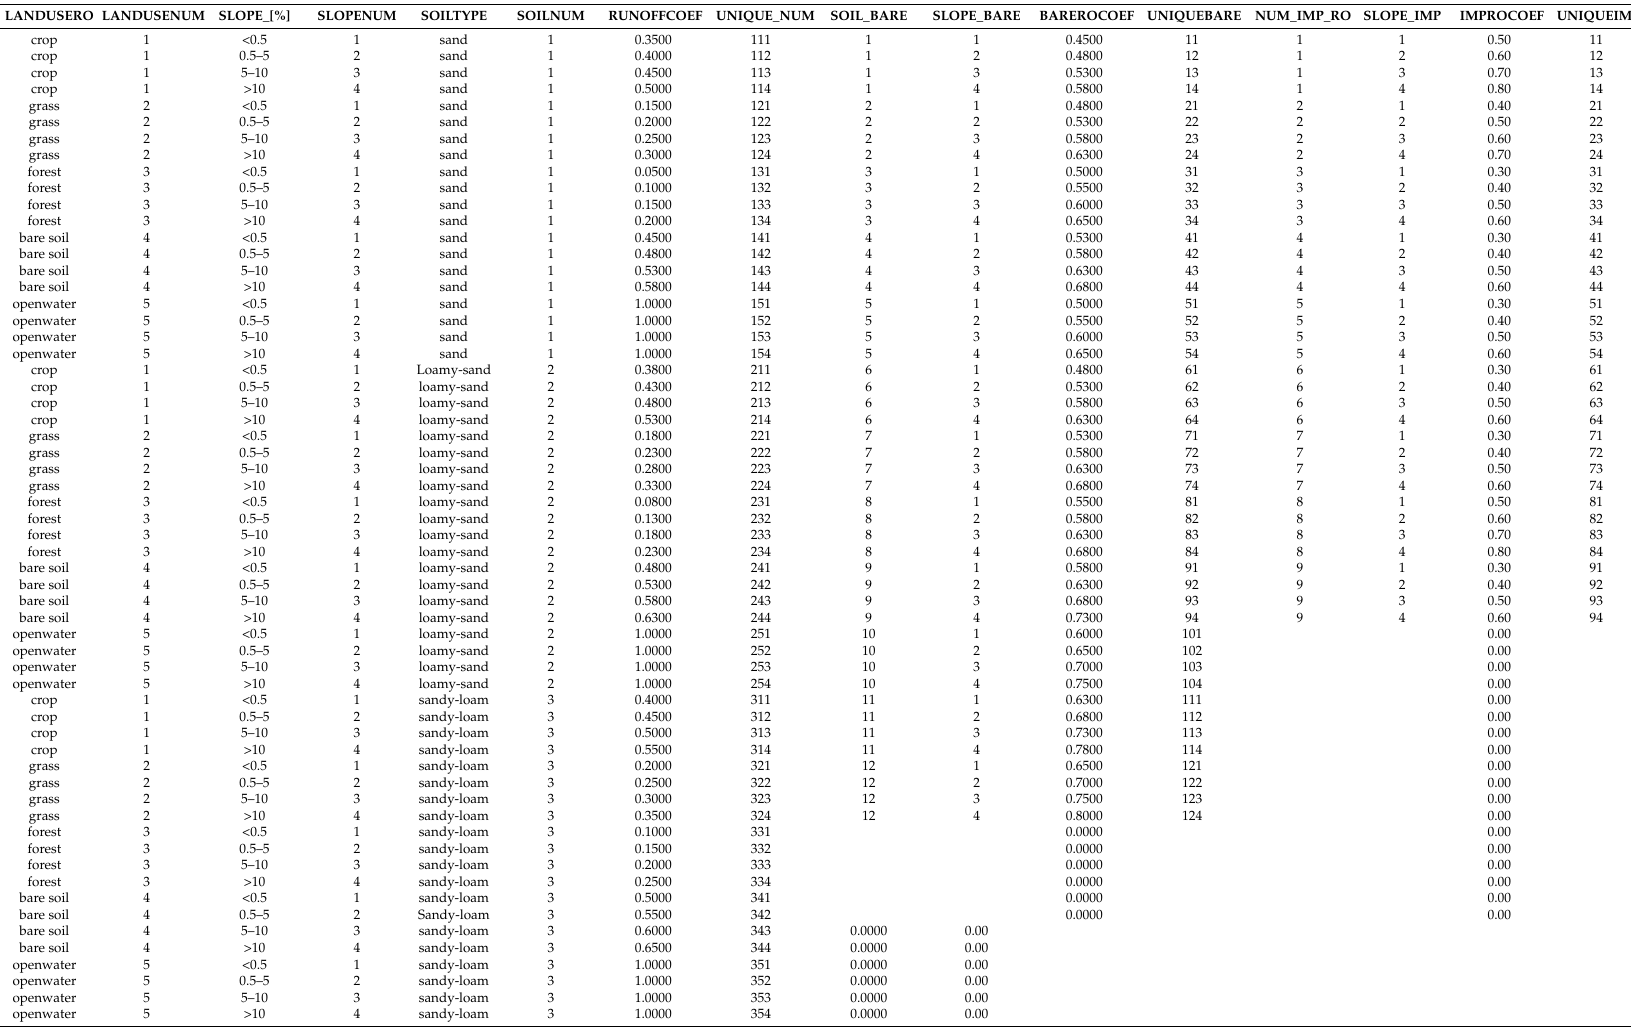
Table A3. Runoff coefficient parameters for vegetated, bare soil and open water raster